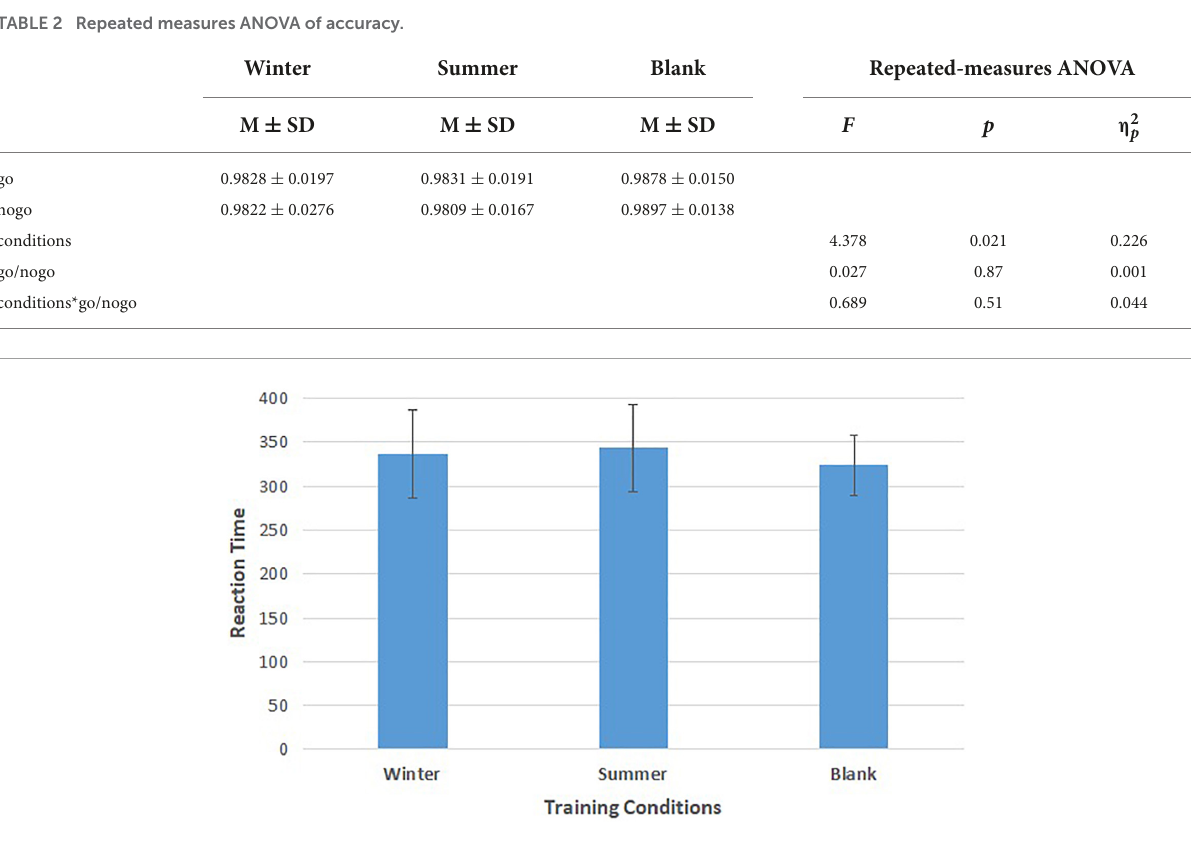
the reaction times of the go task and calculating the accuracy of the go/nogo task. Repeated measures ANOVA was used to assess the effect of training conditions (winter, summer and blank) on the reaction time of the